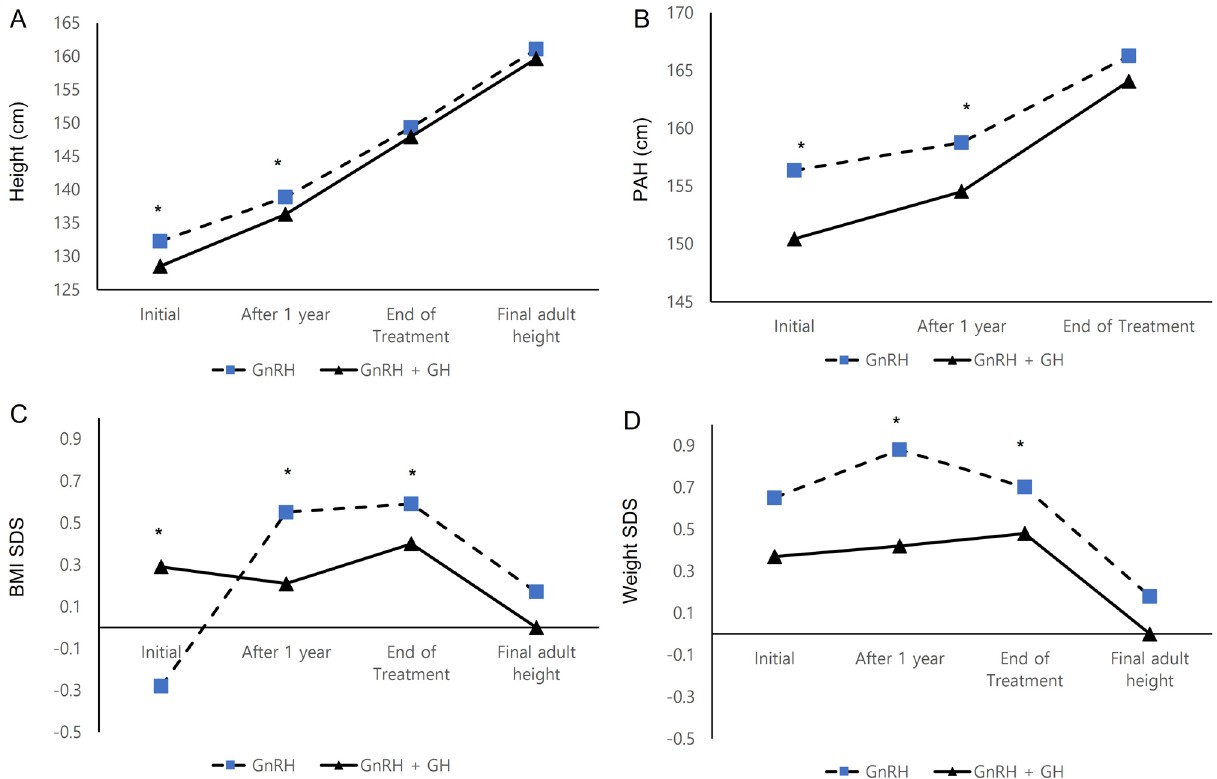
Figure 1. Comparison of height, PAH, BMI SDS and Weight SDS during treatment periods. PAH Predicted adult height, BMI Body mass index, SDS Standard deviation score. * P < 0.05 between GnRHa group and the GnRHa plus GH group.